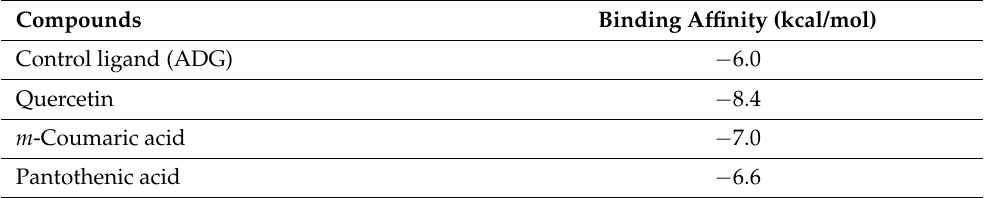
Table 5. Binding affinity values of α -glucosidase enzyme with the identified compounds determined by